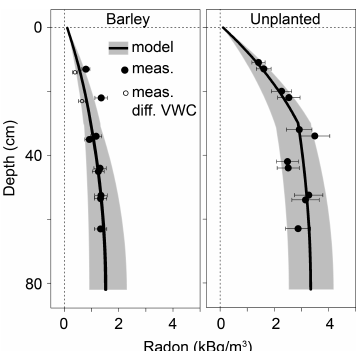
Figure 4. Measured and modeled Rn profiles in barley mesocosms of growth treatment #2 and in unplanted mesocosms. Open symbols indicate Rn measurements taken at lower volumetric water content (VWC) than the remaining samples. Grey shaded areas designate model calculations carried out with diffusivities within the stated confidence intervals (see